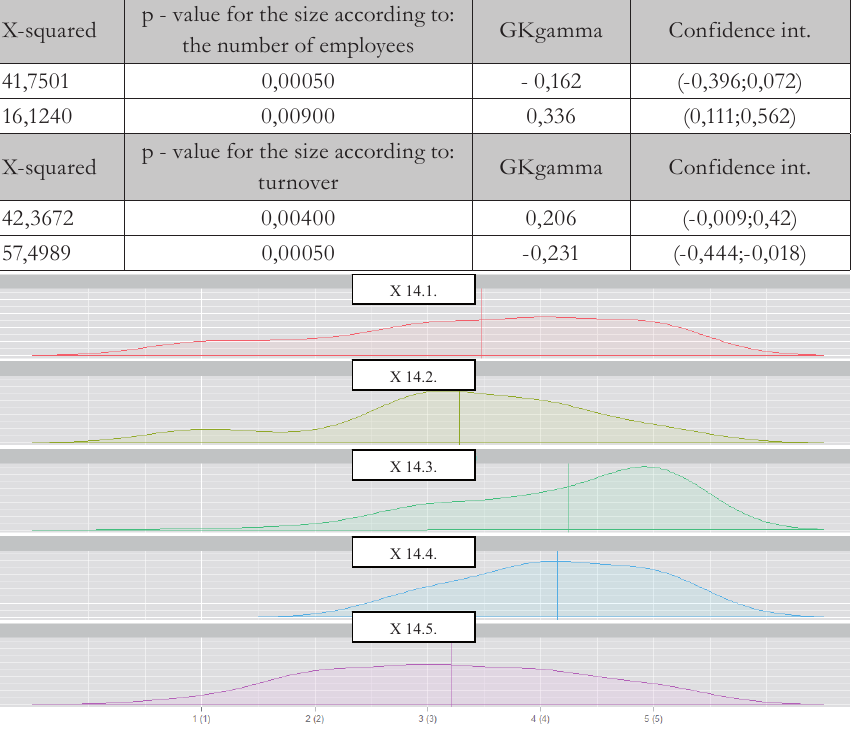
Tab. 4 – Usage of different ways of process segmentation in companies (2013): statistical evalu- ation. Source: own